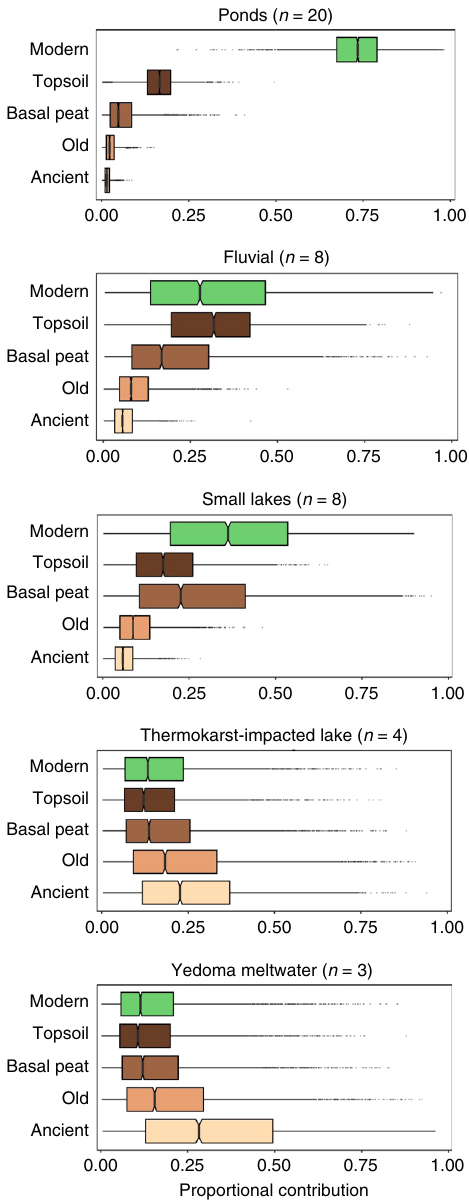
Fig. 3 Relative source contributions to total inland water carbon. Estimated from a fi ve-source Bayesian isotope mass balance model: modern (2013) atmospheric carbon dioxide (CO 2 ); recent, 1950 – 2012 carbon fi xed into plant and soil organic matter in the topsoil; basal peat ages measured at the site representing the oldest carbon available from Holocene peat accumulation (250 – 1180 yBP)); old carbon in late- Pleistocene to early Holocene soils (1765 – 9970 yBP); and ancient Pleistocene-aged Yedoma carbon (>27,920 yBP; Fig. 2a) 6,7,22 . Notched lines in the boxes represent the median, limits represent upper and lower quartiles, whiskers extend to 1.5 times the interquartile range, dots represent data points beyond this